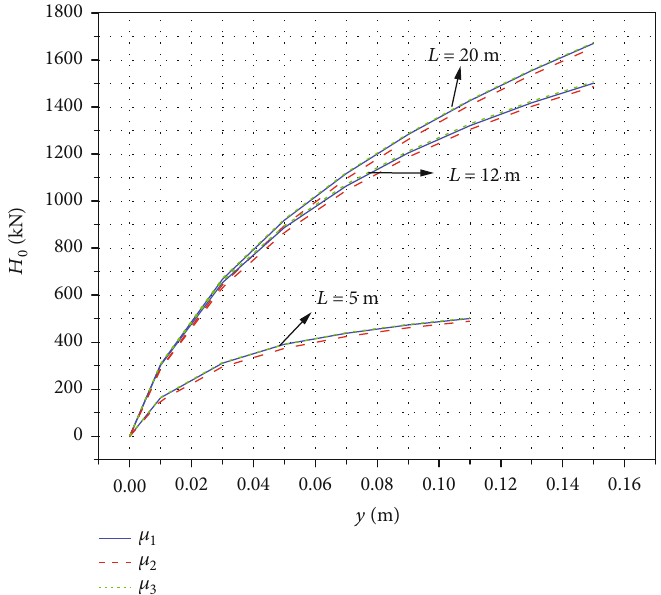
Figure 8: E ff ect of initial sti ff ness reduction factor on pile head de fl